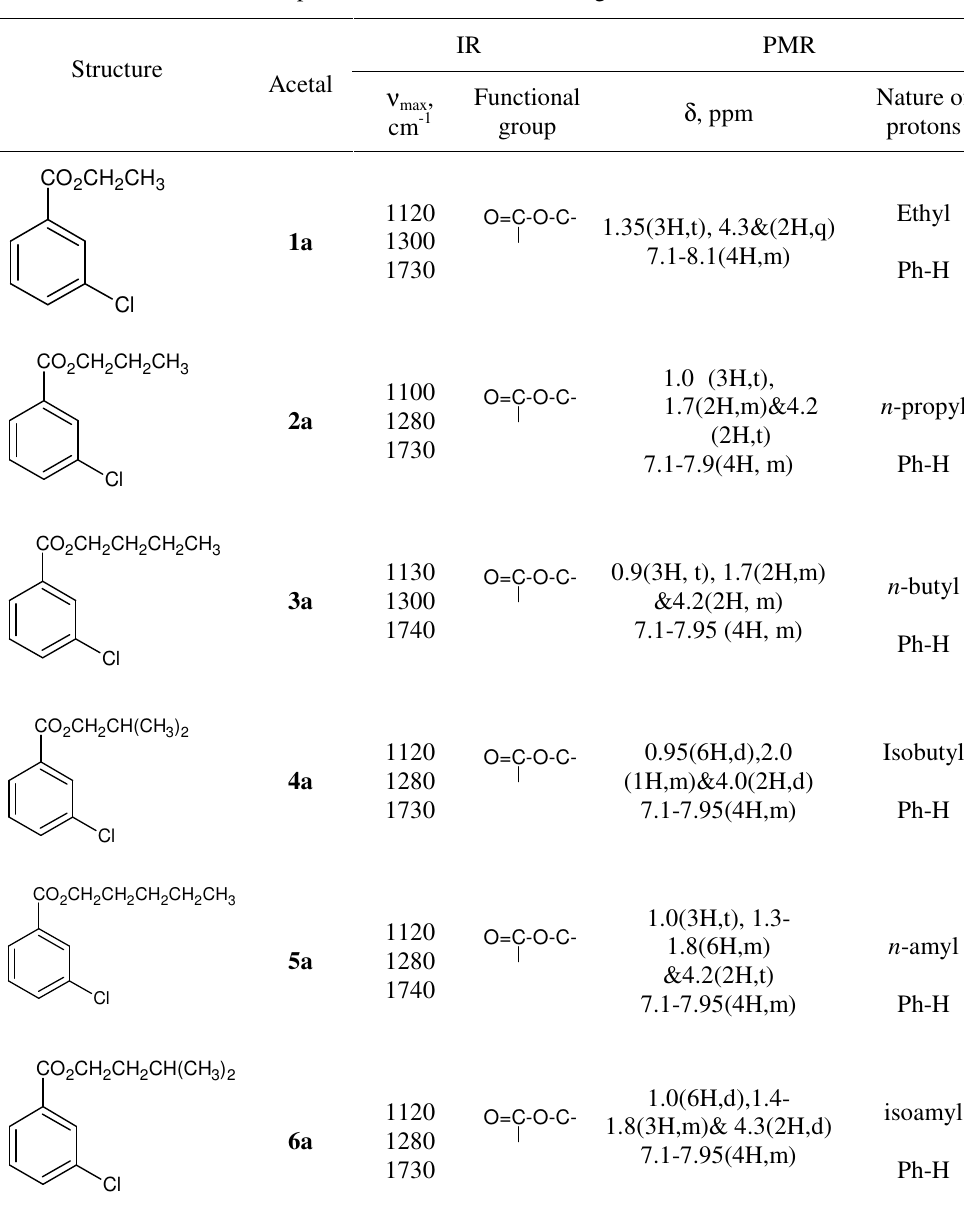
Table 1. Spectra characterizations of ring chlorinated